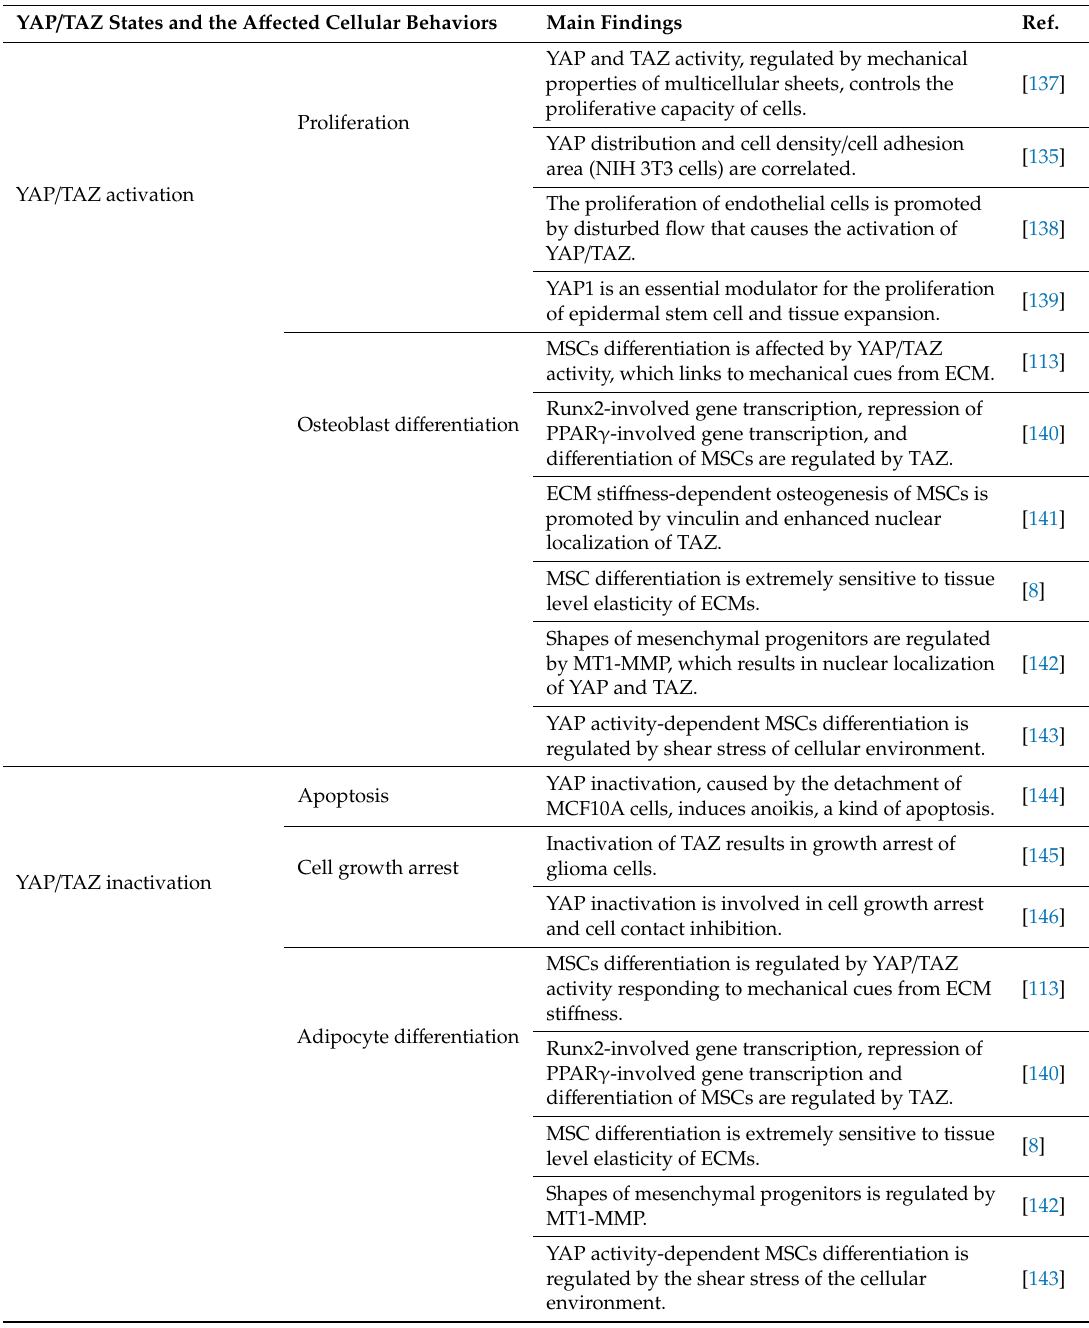
Table 9. Activation / inactivation of YAP / TAZ a ff ects cellular